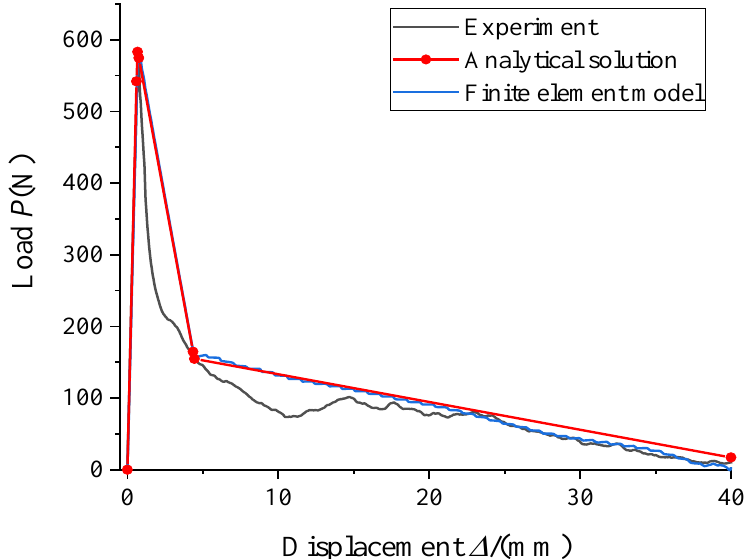
Figure 23. Load–displacement curves from the pullout tests, analytical solutions and FE simula- tions (group ZH).